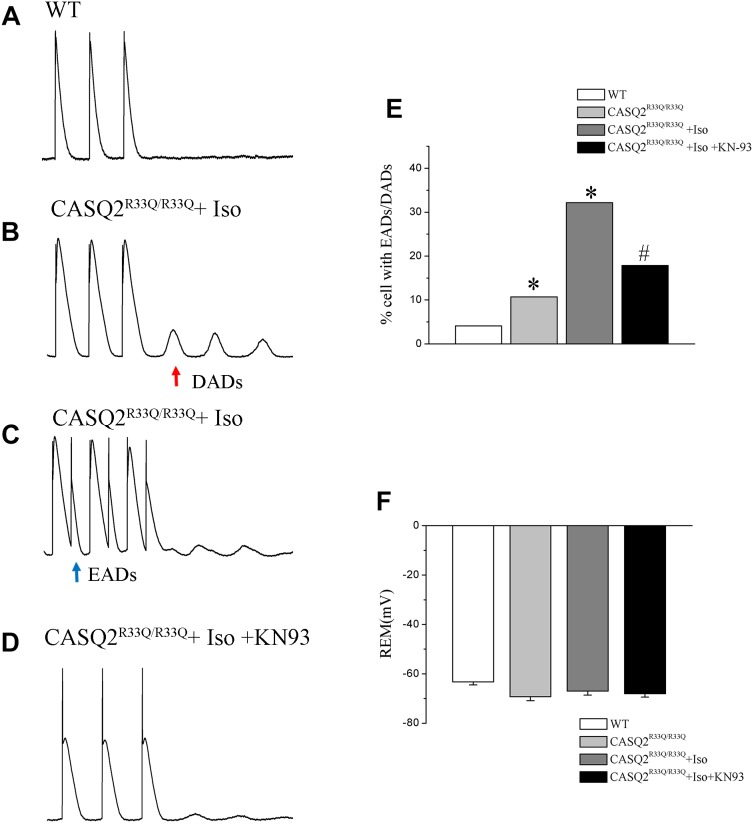
(A,B) The occurrence of Ca2+ spark in Casq2R33Q/R33Q atrial myocytes with or without Iso, and (C,D) the effect of KN92 and KN93 on Casq2R33Q/R33Q atrial myocytes with 1 μM isoproterenol. Comparison of the (E) Ca2+ spark frequency and (F) baseline Ca2+ concentration among groups. ∗P < 0.05 vs. WT, ∗∗P < 0.01 vs. WT. #P < 0.05 when comparing the Iso group with the Iso plus KN92/KN93 group.